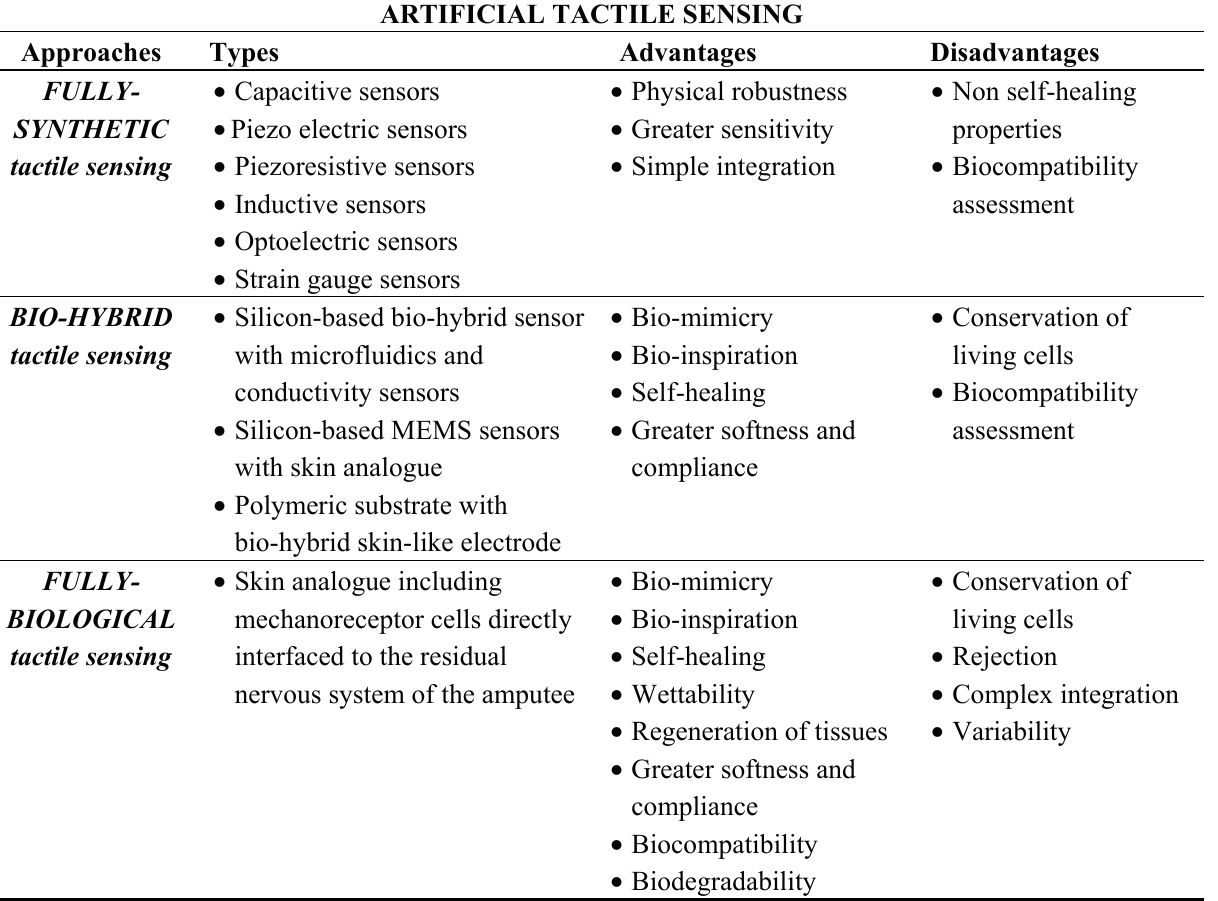
Table 1. Comparison between different approaches towards artificial tactile sensing, adapted from